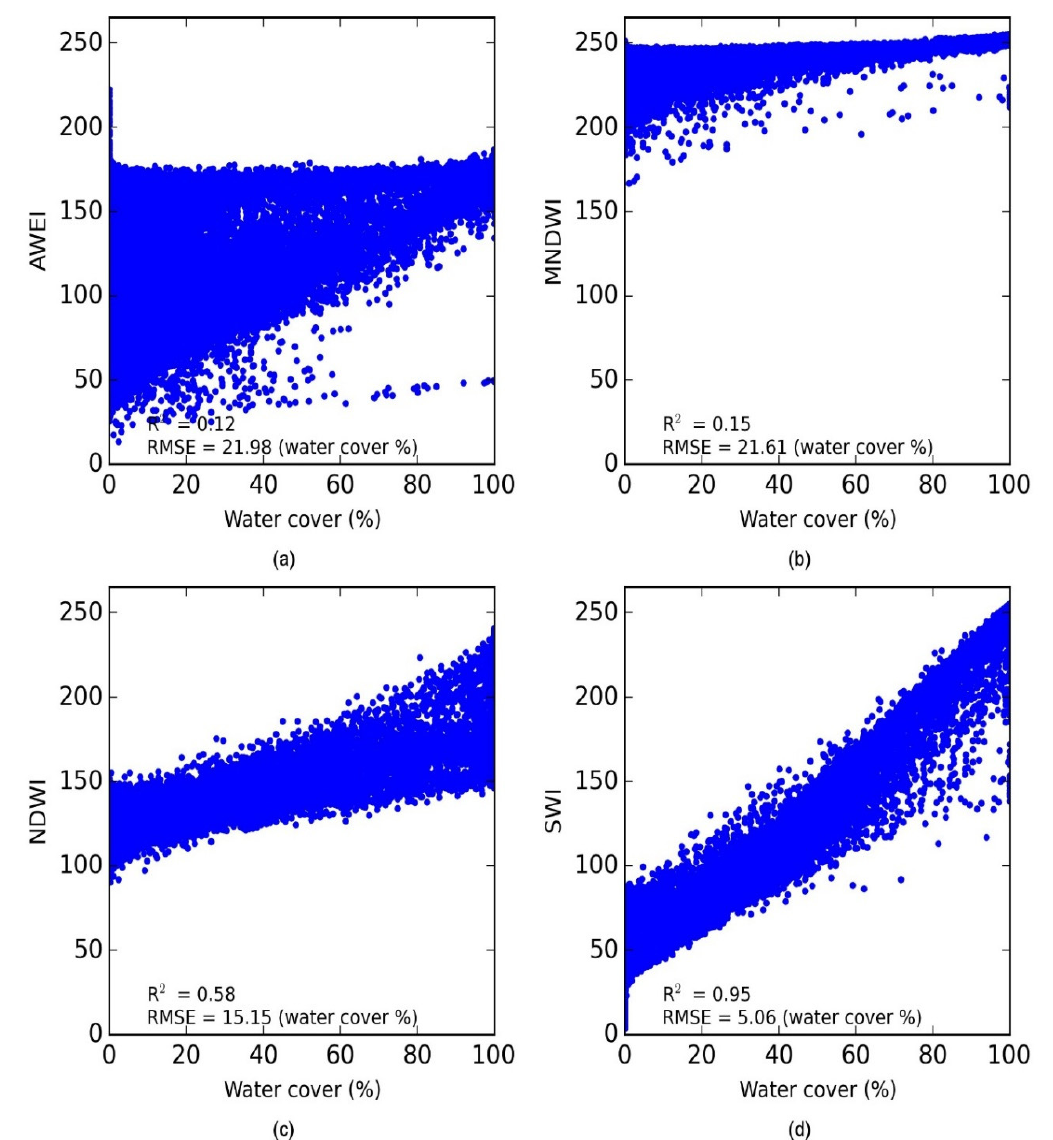
Figure 4. The sensitivity of different water indices to the water cover in a snowy region: ( a ) Automated Water Extraction Index (AWEI) vs. water cover, ( b ) Modified Normalized Difference Water Index (MNDWI) vs. water cover, ( c ) Normalized Difference Water Index (NDWI) vs. water cover, ( d ) Superfine Water Index (SWI) vs. water